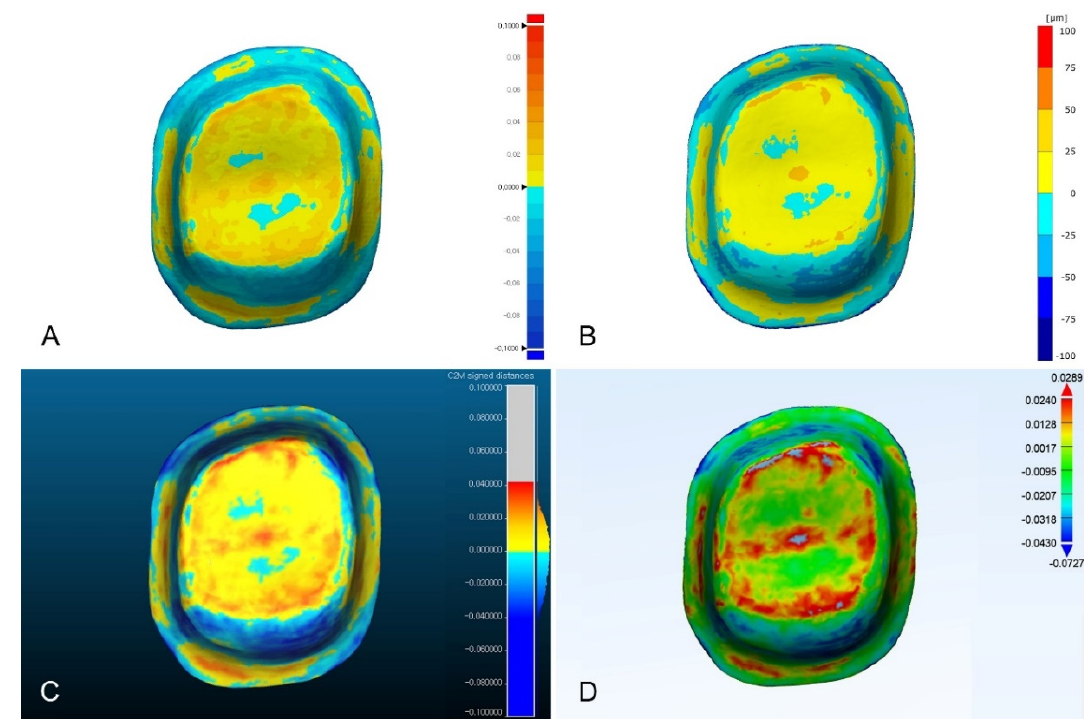
Figure 5. Comparison of color difference maps of tooth preparation region evaluated by using four analysis software programs: ( A ) Geomagic control X; ( B ) GOM Inspect; ( C ) Cloudcompare; ( D ) Materialise 3-matic.